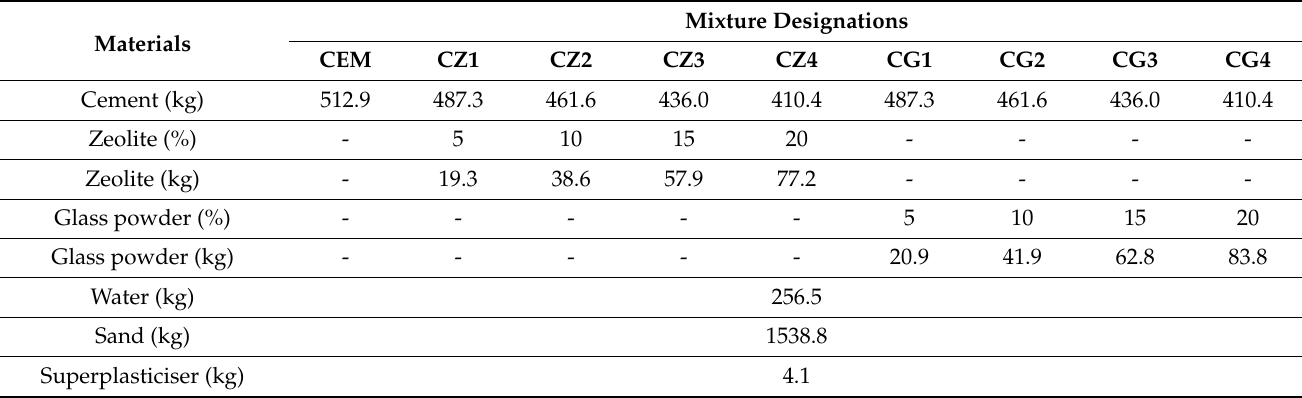
Table 3. Compositions of cement mortars No 1 (for the mixture volume of 1 m 3 ).